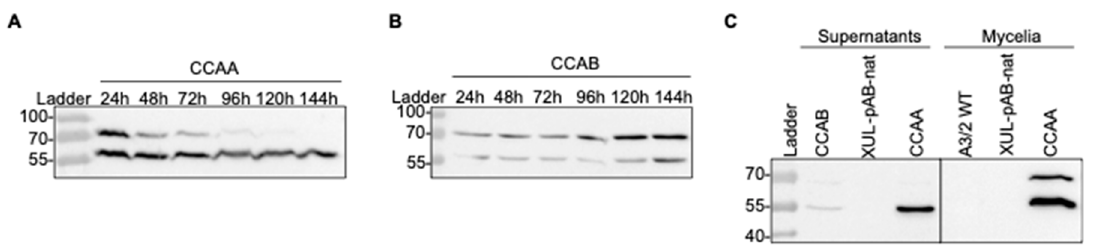
Figure 6. Extensive investigation of the CCA synthesis and processing in A. chrysogenum. ( A ) The expression and cleavage process of CCAA over time from mycelia of transformant XUL-4.6. ( B ) Time course of expression and cleavage of CCAB from transformant XUL-22.3. ( C ) Detection of processed CCAA (XUL-4.6) and CCAB (XUL-22.3) in extracts from mycelia and supernatants. As indicated, samples from the wild-type (A2/3 WT) or transformants carrying pAB-nat plasmid (XUL-pAB-nat) served as